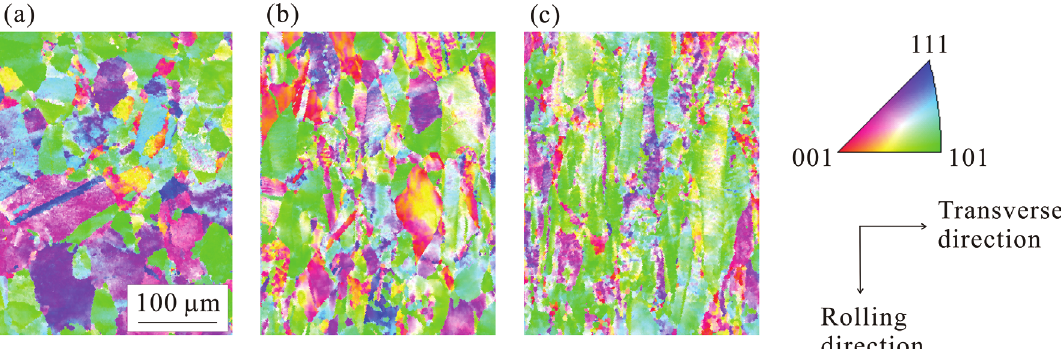
Figure 3: ND-IPF maps of cold-rolled pure copper at rolling reductions of (a) 30, (b) 50, and (c) 75%.